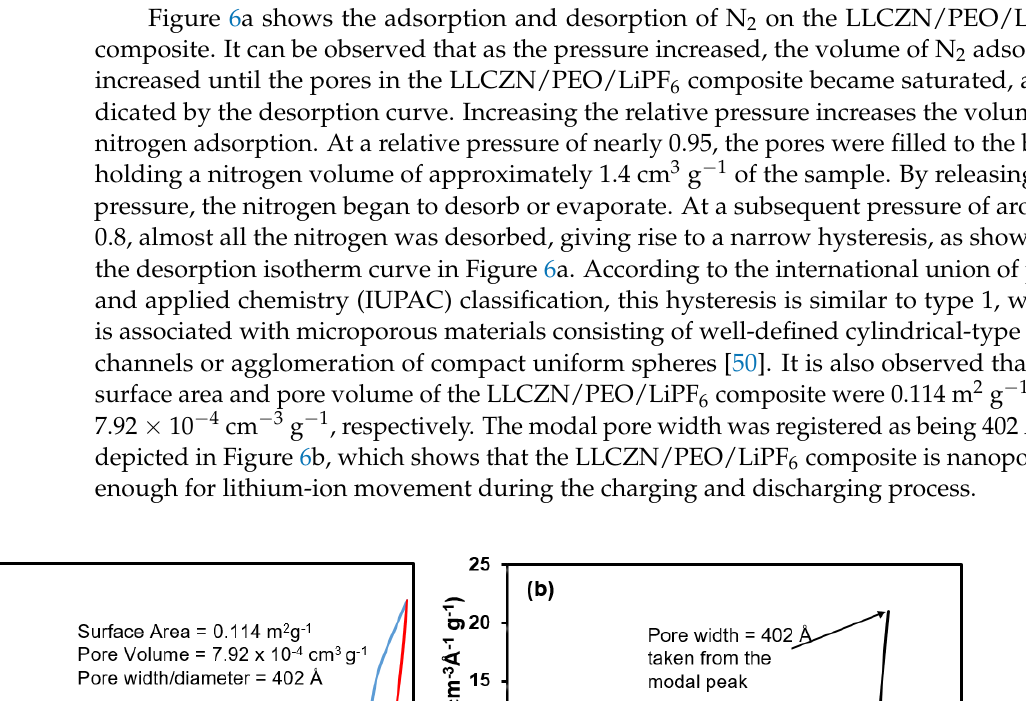
Figure 5. Thermogravimetric analysis (TGA) of LLCZN/PEO/LiPF 6 composite and the insert is pris- tine LLCZN powder.